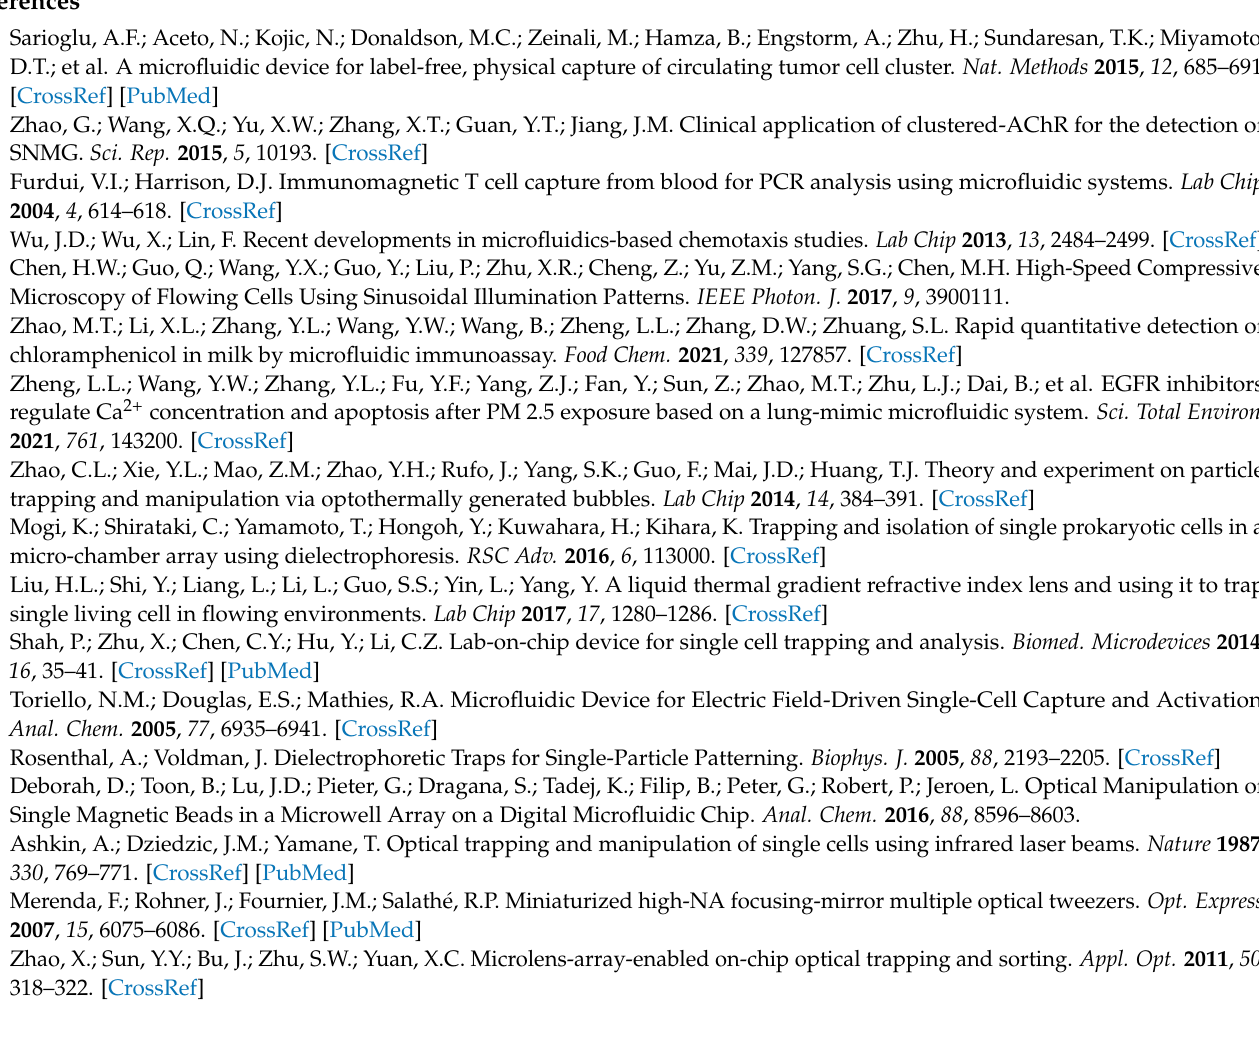
Figure S2: Model of the dentate spiral microfluidic channel used in the simulation, Figure S3: (a) Simulation of the flow in the structure with w / s = 3, when all the traps are empty. (b) Simulation of the flow in the structure with w / s = 3, when a part of traps are occupied. (c) The normalized pressure measured at different positions as marked in (a) and (b)., Figure S4: The flow in the dentate spiral channel with the 140 µ m main channel and the 10 µ m gap, Figure S5: The microscopic images of the 4T1 cells used in the cell-trapping